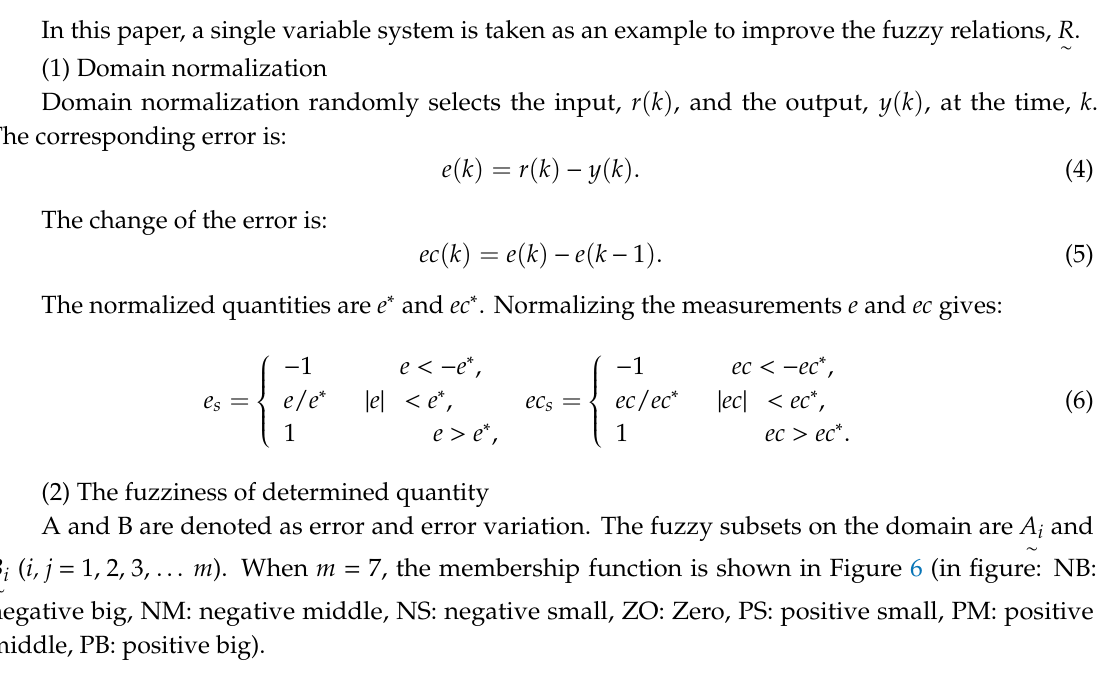
Figure 5. Self-learning fuzzy controller structure.